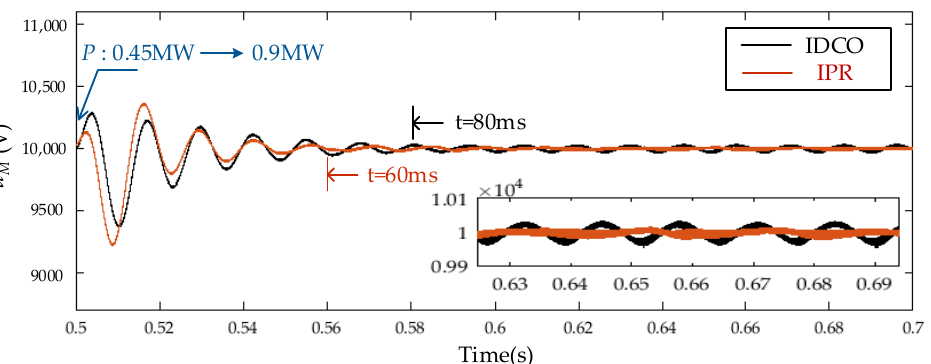
Figure 20. Dynamic waveforms of the MV bus voltage u M based on the IDCO or IPR control method under a load step-change.